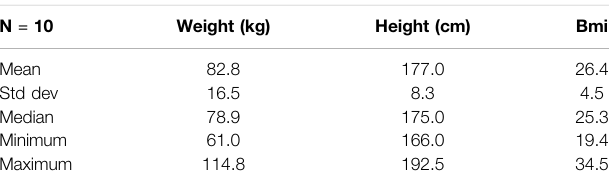
TABLE 2 | Trial subject demographic